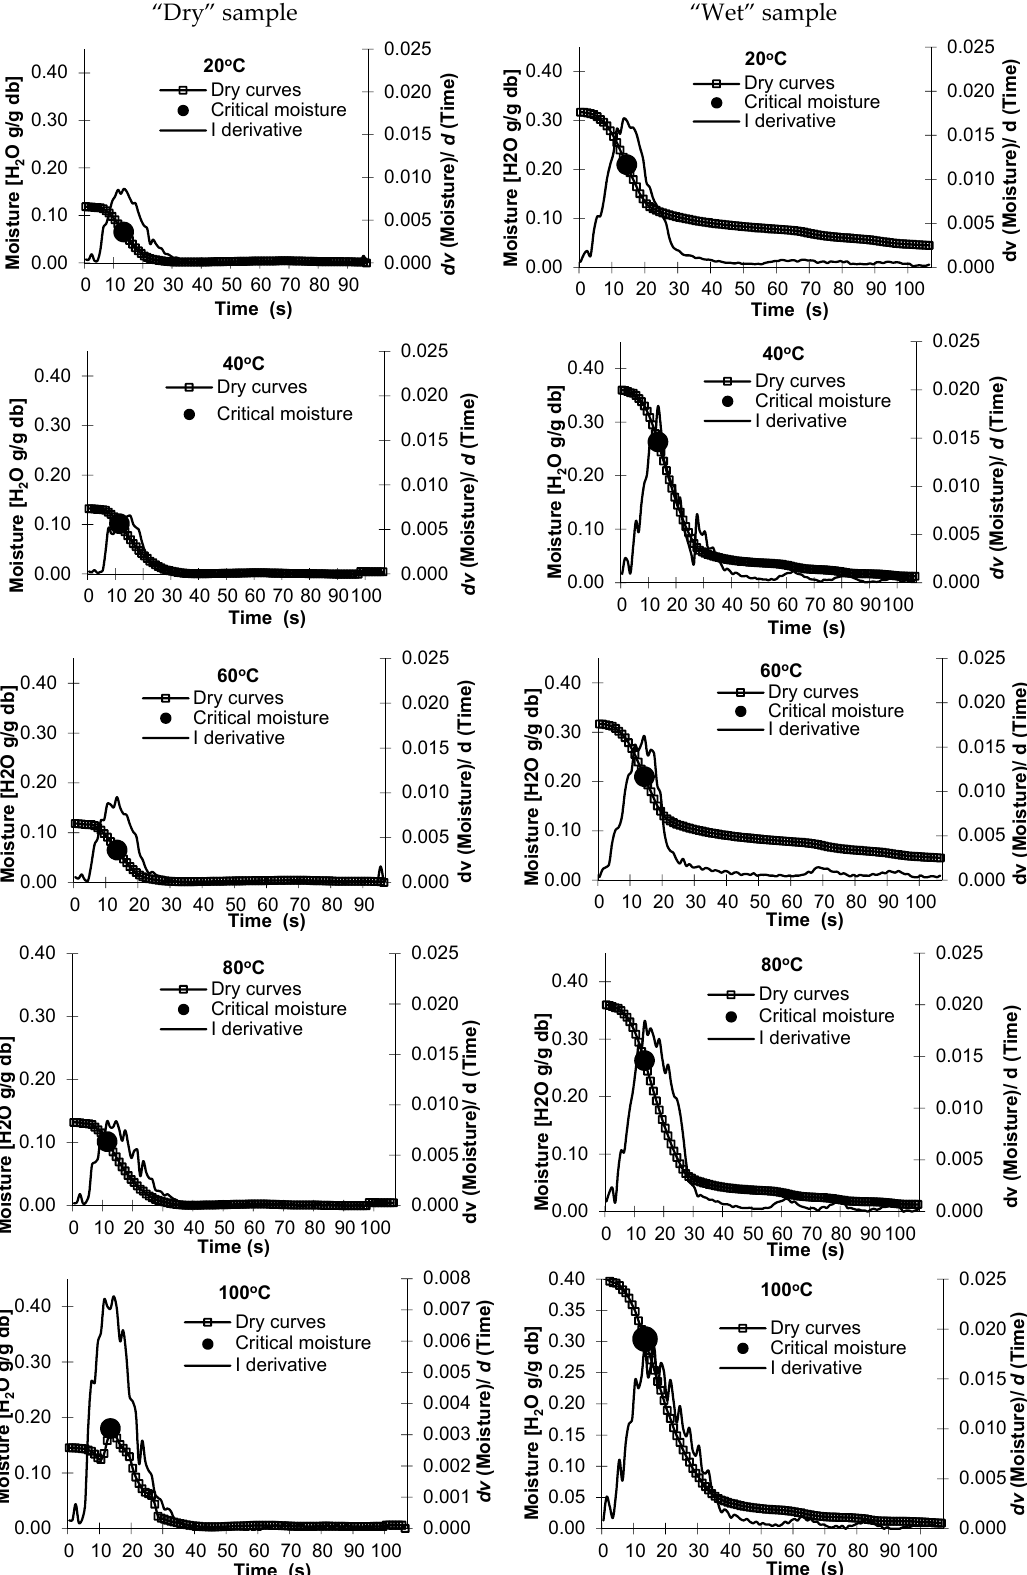
Table 1. Surface area of the analysed starches. Code